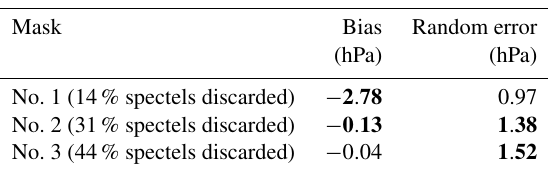
Table D2. Results of the inversion of Psurf in MicroCarb band B4 (1.27µm) with method no. 2 (spectel mask). Values printed in bold are non-compliant with MicroCarb requirement. Non-bold indicates compliant